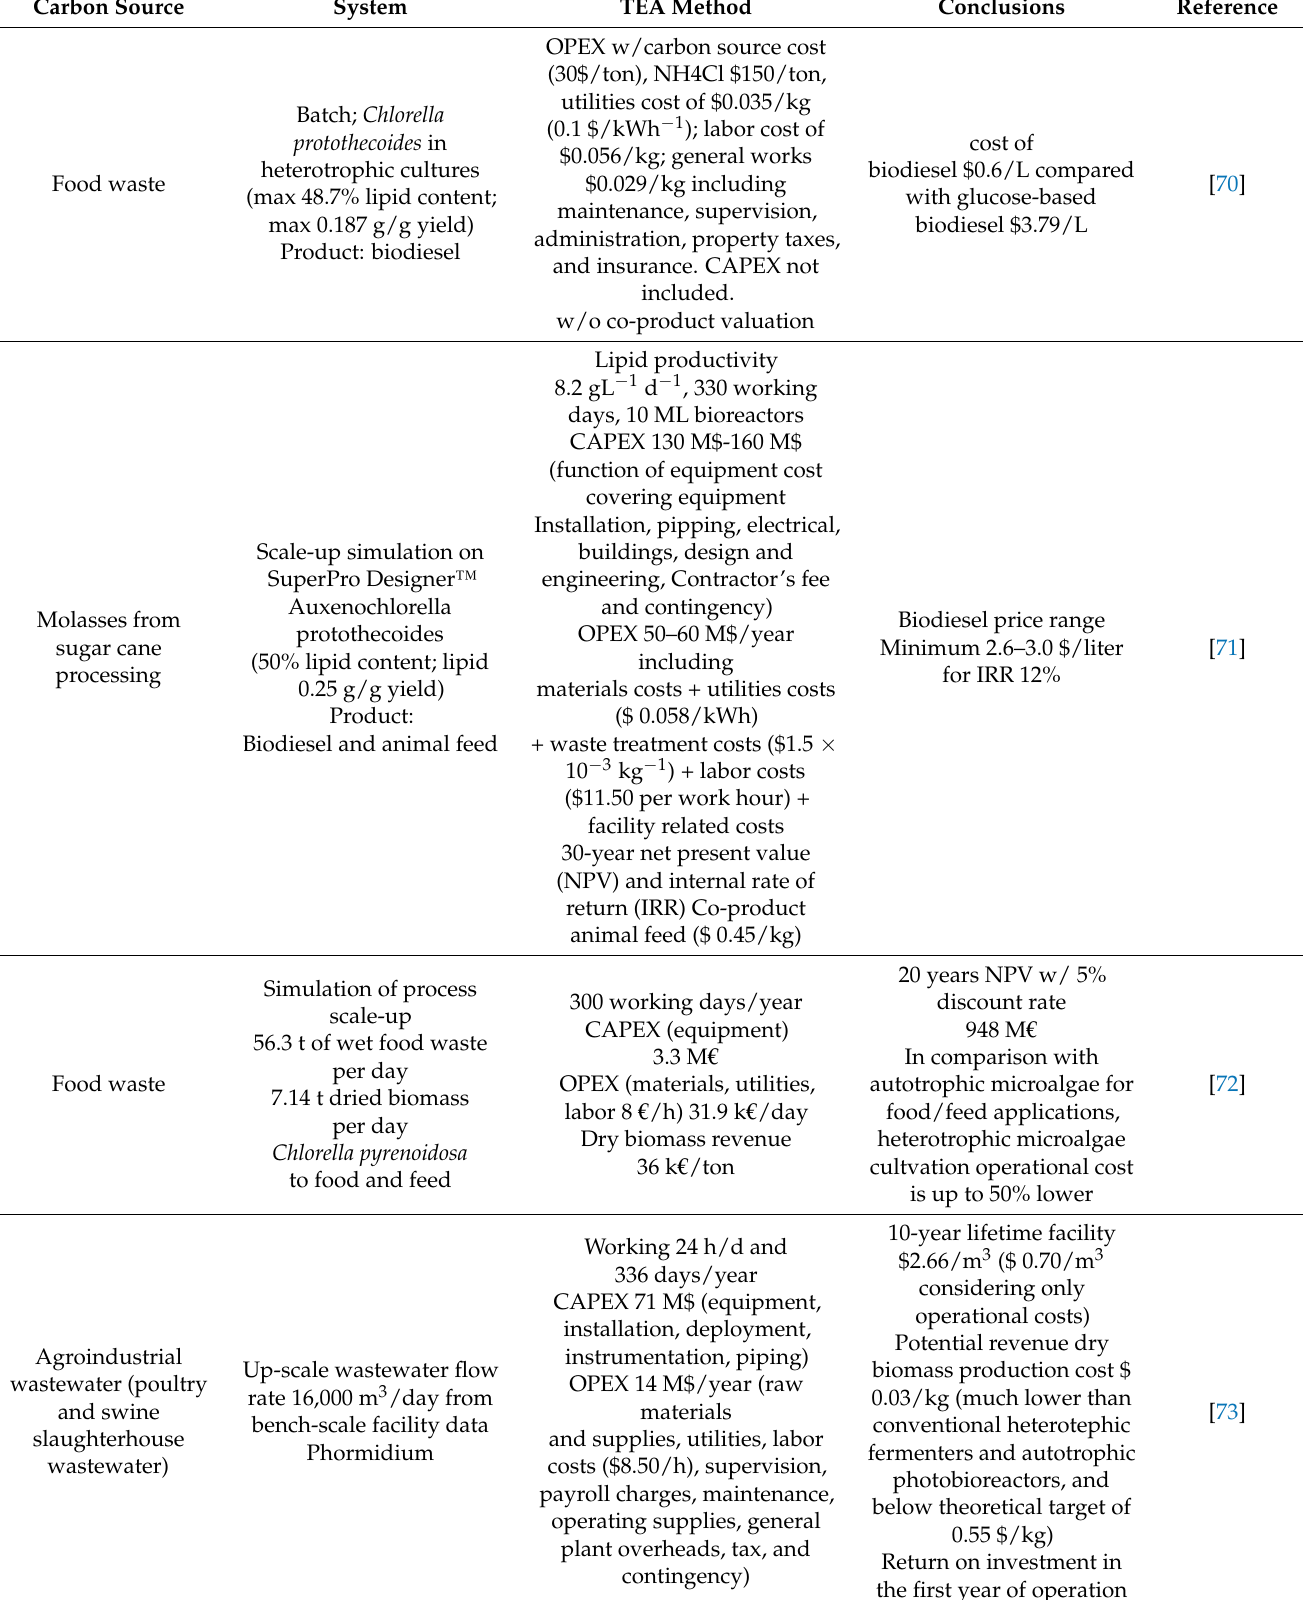
Table 3. Summary of TEA studies focused on heterotrophic